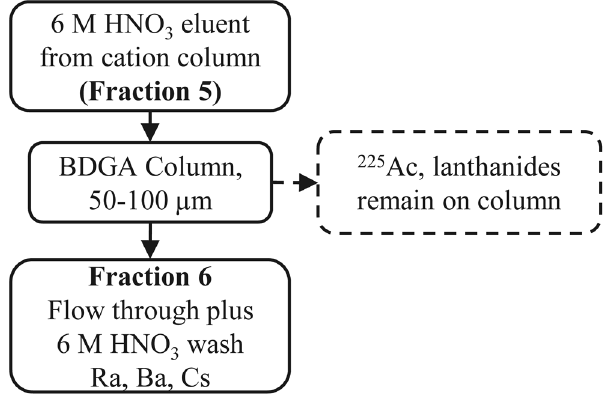
Figure 2. TEHDGA Extraction